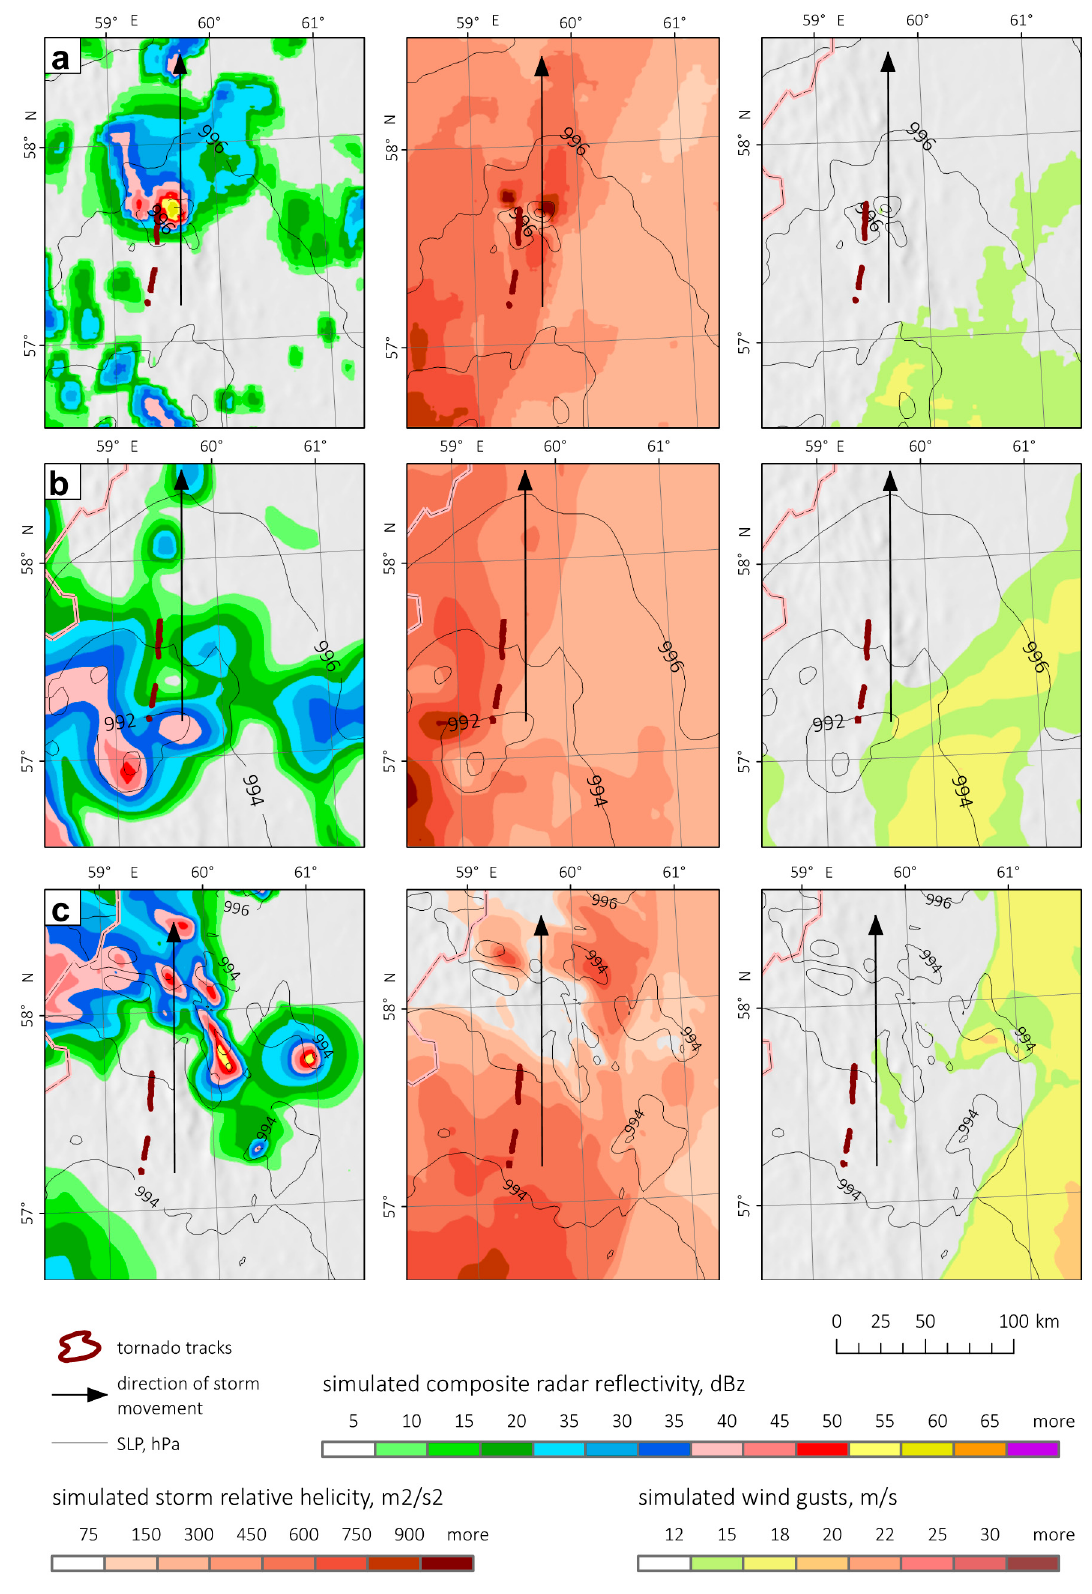
Figure 9. WRF-simulated composite reflectivity (dBz), storm-relative helicity (m 2 s − 2 ), and wind gusts (m s − 1 ) at 1200 UTC 3 June 2017 with different model grid resolution settings: 3 km with no nested grid ( a ), 7.2 km with no nested grid ( b ), and 9 km with 3-km nested grid ( c ).